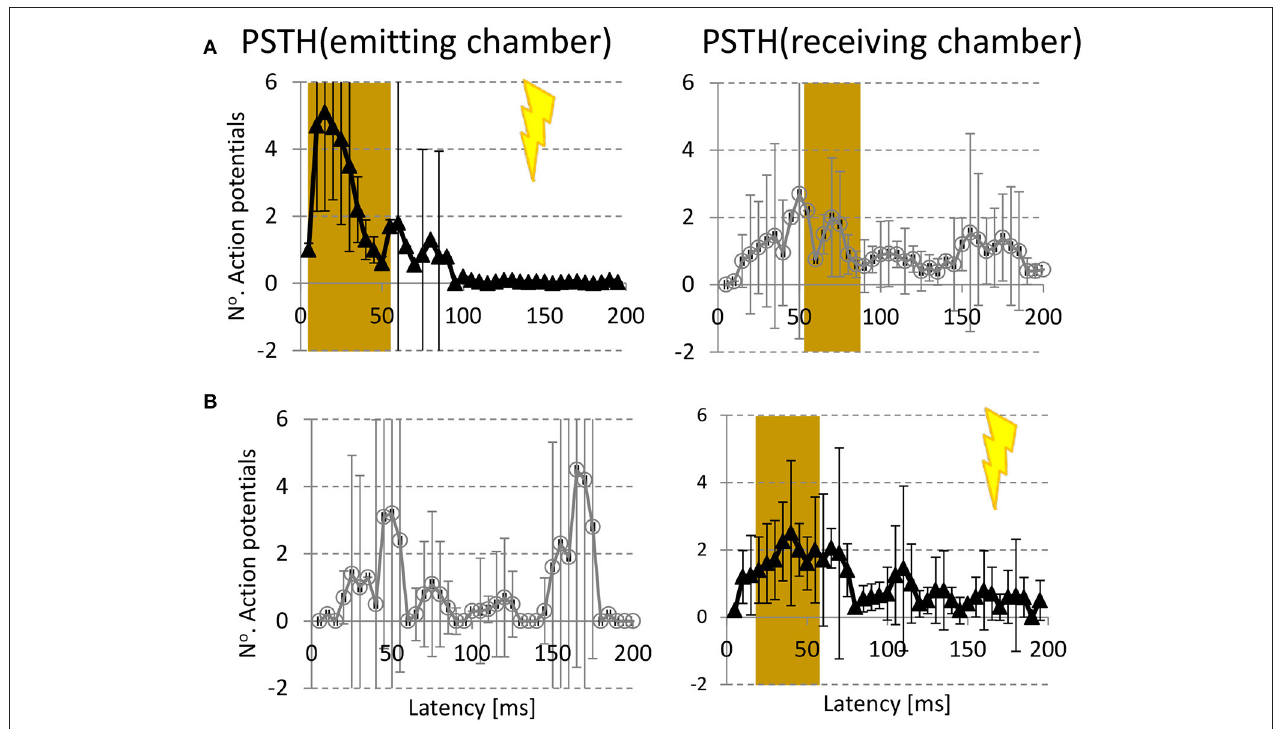
FIGURE 4 | Stimulus responses. (A) Average post stimulus time histogram (PSTH) in emitting (left column) and receiving chamber (right column) to electrical stimulation in emitting chamber ( ) (B) PSTH(emitting chamber) and PSTH (receiving chamber) in response to stimulation in the receiving chamber ( ). Error bars indicate 95% confidence intervals ( = 1.96 × SEM), and represent differences between experiments ( n = 12 ). Responses were considered significant if the 95% confidence interval did not include 0 in 2 consecutive time bins. Significant responses are indicated by brown